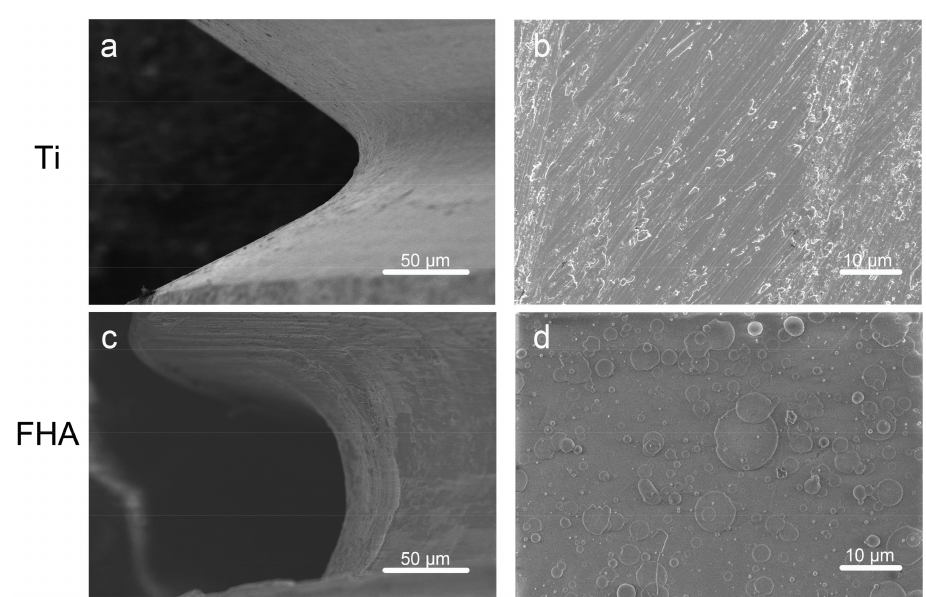
Figure 2. Scanning electron micrographs of ( a , b ) Ti and ( c , d ) FHA-coated screws.